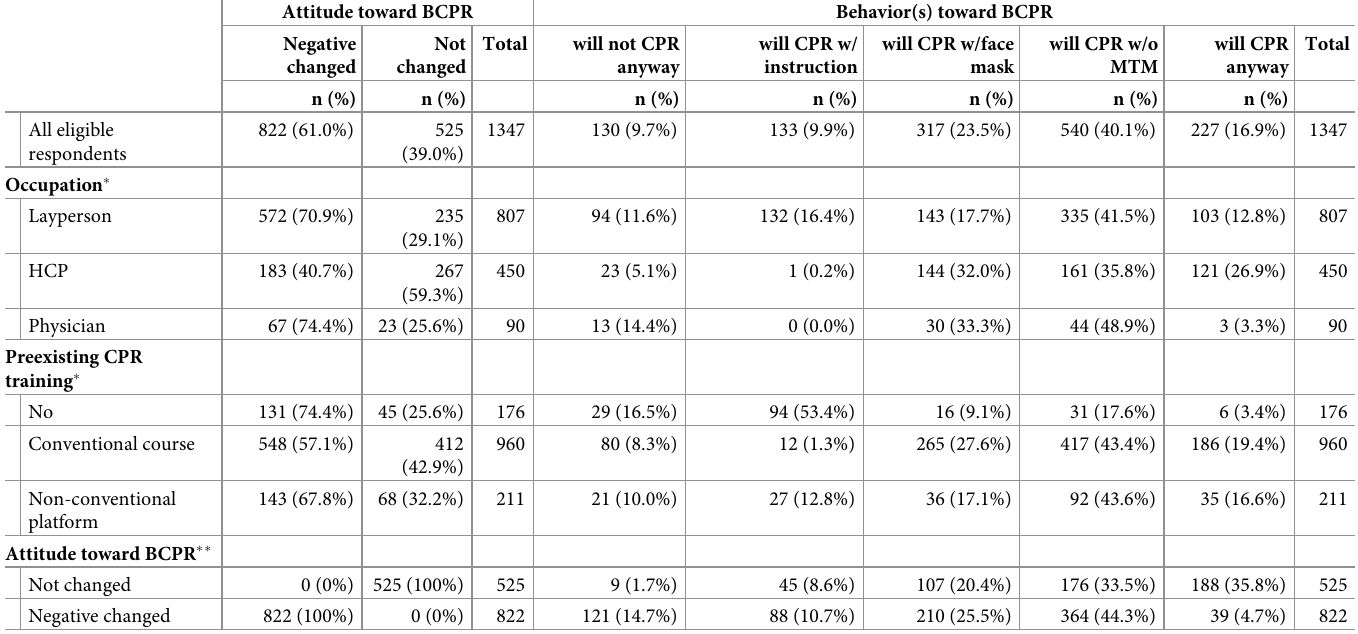
Table 2. Univariate association between survey predictors and willingness toward BCPR: All eligible